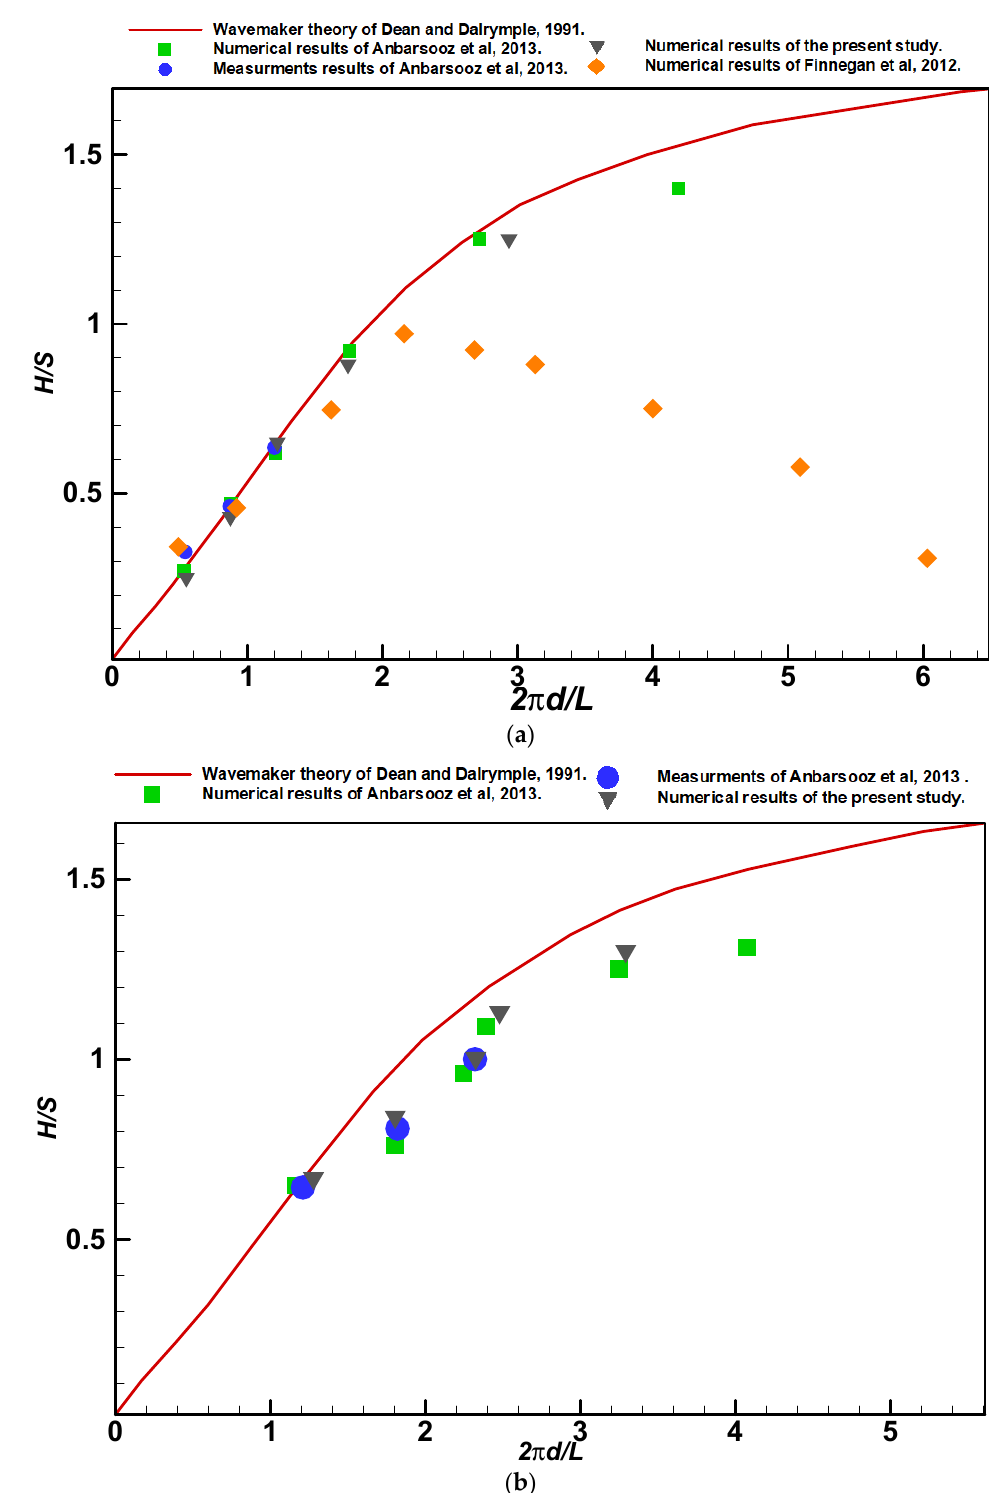
Figure 16. Comparison of the present results with other studies for ( a ) small wave steepness and ( b ) high wave steepness [4,22,30].